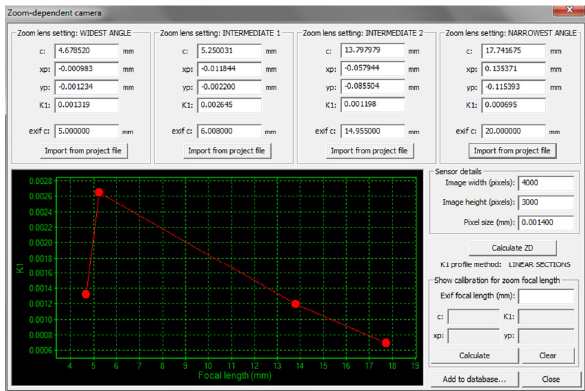
Figure 5. K 1 values for a Canon Powershot SD1300 IS camera.